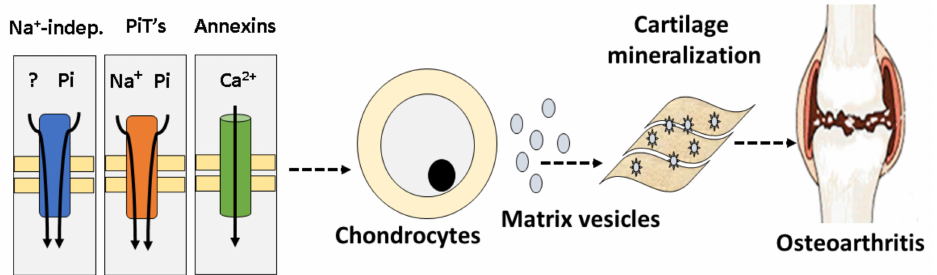
Figure 4. Schematic of the role of sodium-independent Pi transport in the development of osteoarthritis. Na + -independent and Na + -dependent Pi transport (PiT-1 and PiT-2) and annexins (Ca 2 + channels) in